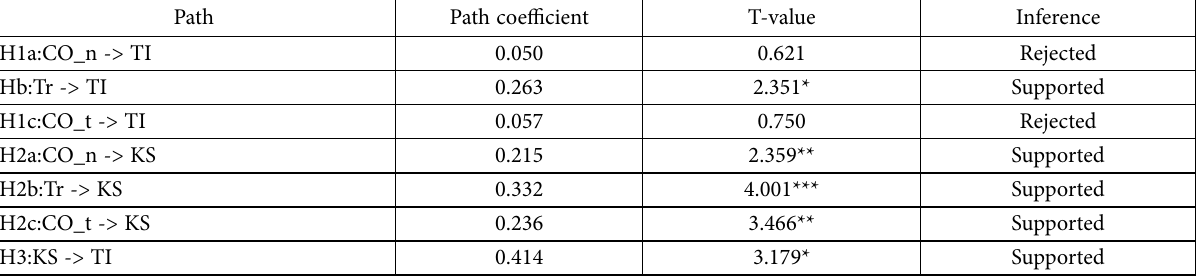
Table 6. Path analysis results of the structural model